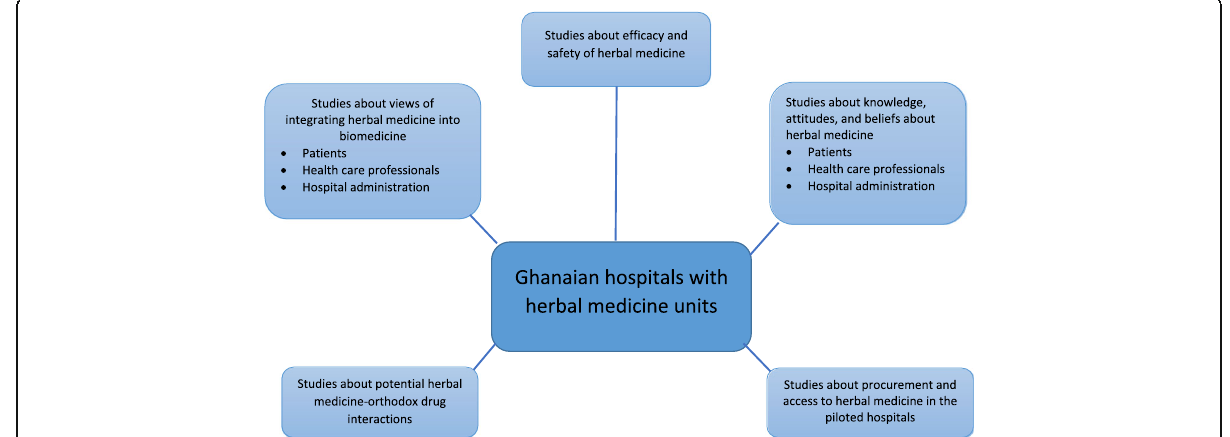
Fig. 1 Types of studies to be conducted in Ghanaian hospitals piloting herbal medicine biomedicine